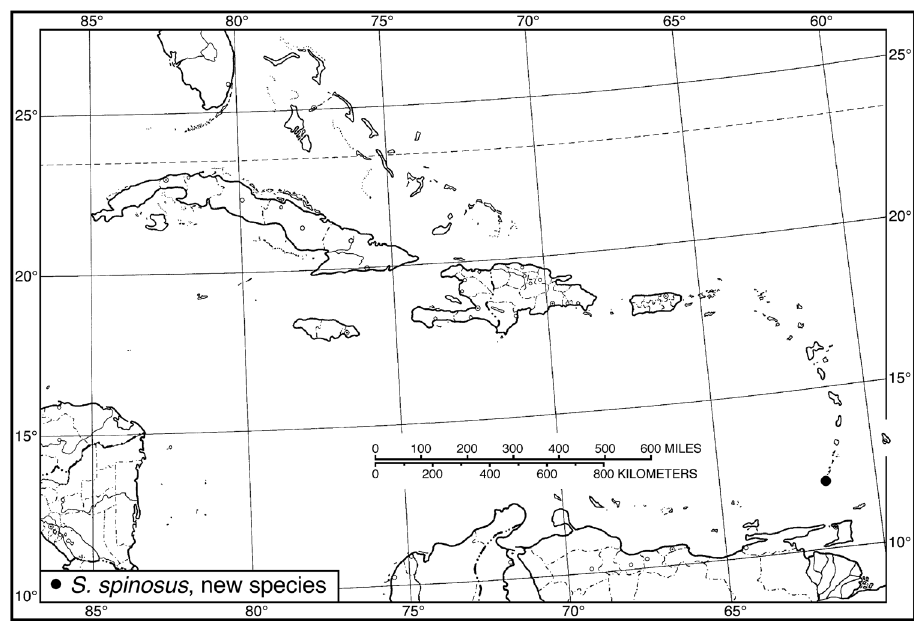
Figure 24. Map of West Indies showing known localities for species of Selenophorus seriatoporus species group.